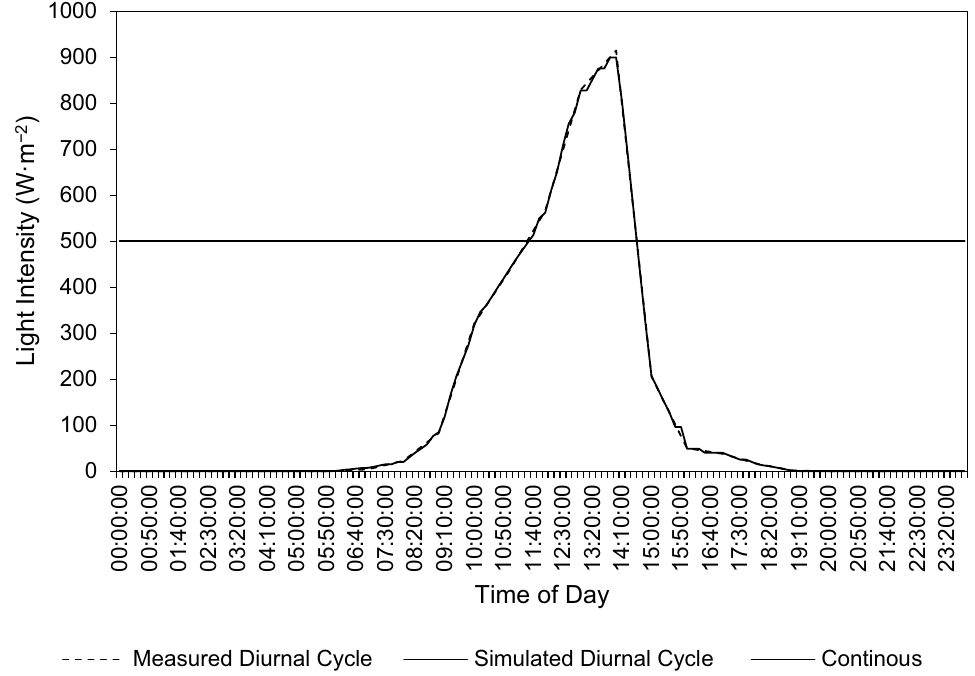
Fig. 1 Measured and simulated 24-h diurnal light cycle, and continuous light intensity (500 W m − 2 ) over